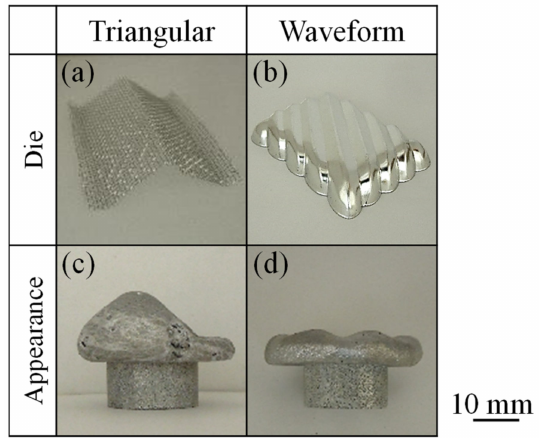
Figure 6. Press formed dies and obtained AC4CH/pAl samples. ( a ) Triangular die. ( b ) Waveform surface die. ( c ) Triangular AC4CH/pAl sample. ( d ) Waveform surface AC4CH/pAl